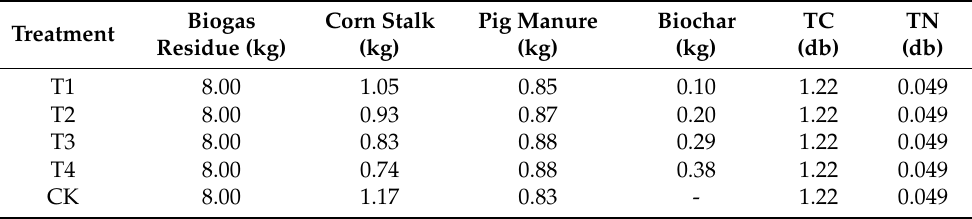
Table 2. Amount of composting materials added in each